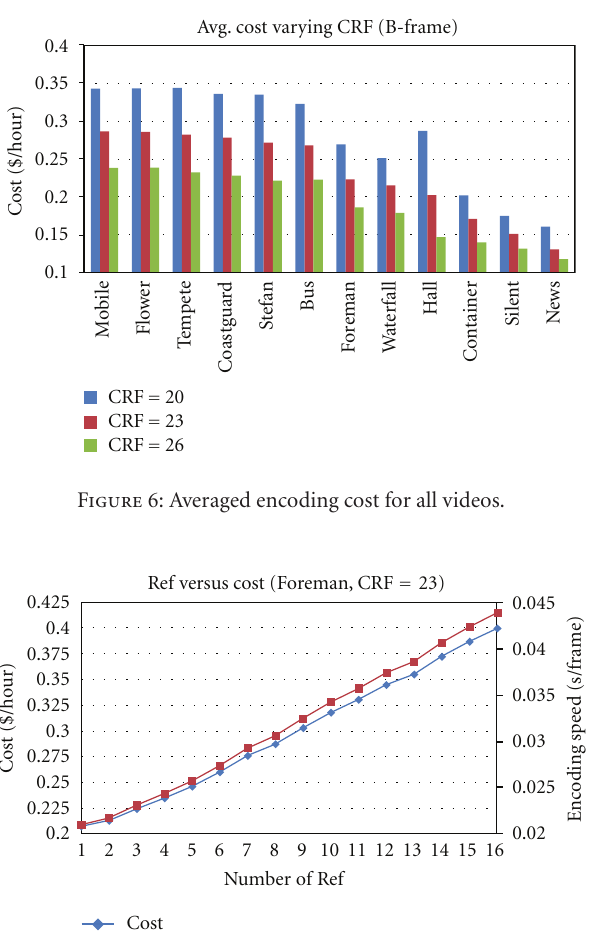
Figure 9: Encoding cost with varying Ref number under di ff erent CRF settings